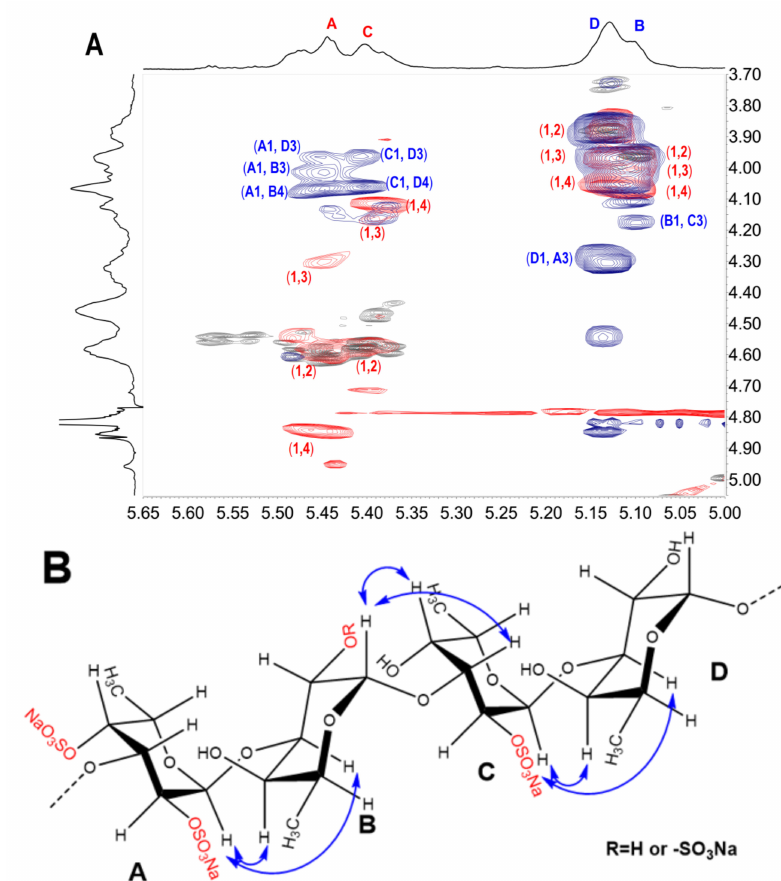
Figure 6. Partial overlapped spectra ( A ) of 1 H- 1 H COSY (gray), ROESY (blue) and TOCSY (red) of depolymerized product (dFSI (cid:48) ) and possible cross-peaks from H-1 in ROESY marked by blue arrows ( B ). The capital letters A, B, C and D represent Fuc 2S4S , Fuc (2S) , Fuc 2S and Fuc,